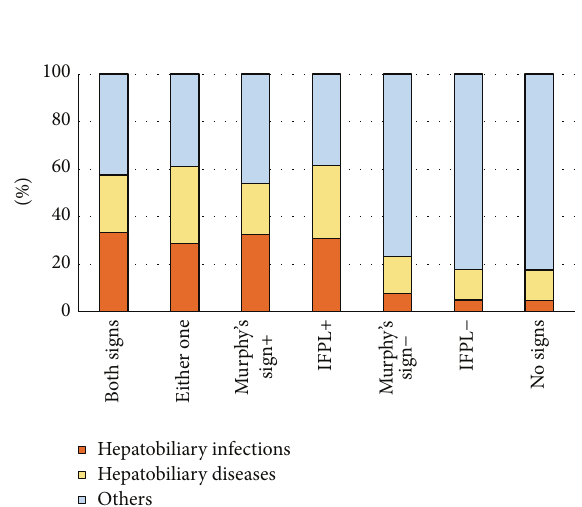
Figure 2: Likelihood of hepatobiliary diseases estimated by Mur- phy’s sign and indirect fist percussion of the liver. The likelihood of hepatobiliary diseases estimated by indirect fist percussion of the liver alone was almost the same as that estimated based on indirect fist percussion of the liver in combination with Murphy’s sign. IFPL: indirect fist percussion of the